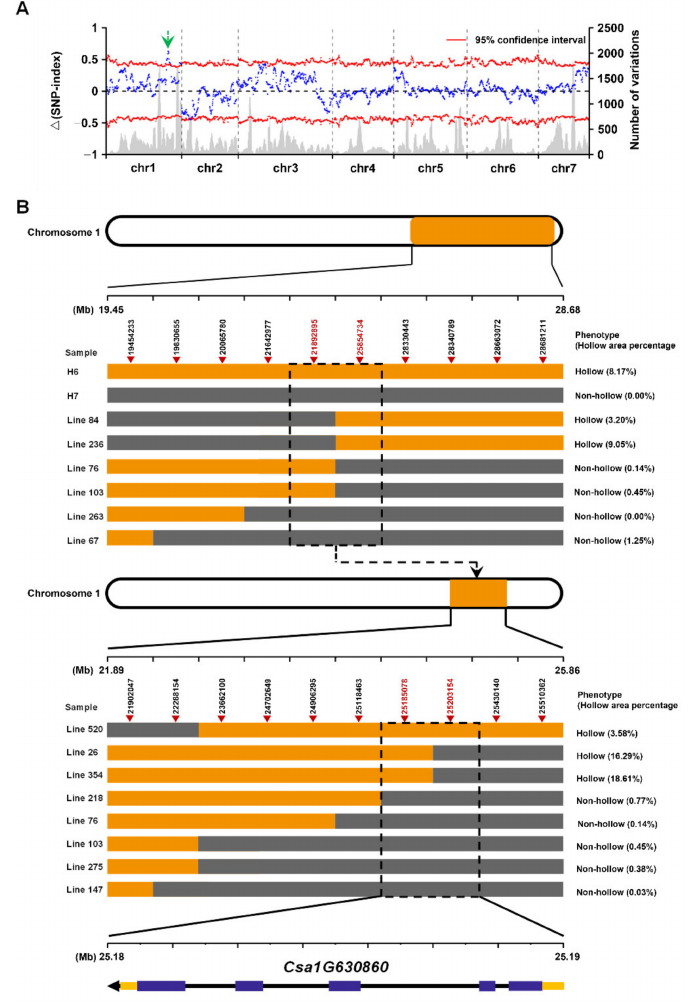
Figure 3. Fine mapping of the hollow gene in cucumber fruit based on genotypes and phenotypes of recombinant individuals: ( A ) Single nucleotide polymorphism (SNP)-index distribution. Blue lines indicate delta SNP-index, gray bars indicate the number of variations, the green arrow indicates the region on chromosome 1 with a SNP index >0.5; ( B ) genotyping analysis using the KASP technique in the F 2 individuals. Gray bars are homozygous for the H7 allele and orange bars are homozygous for the H6 allele. Purple represents exons and yellow represents 5 (cid:48) -UTR and 3 (cid:48)